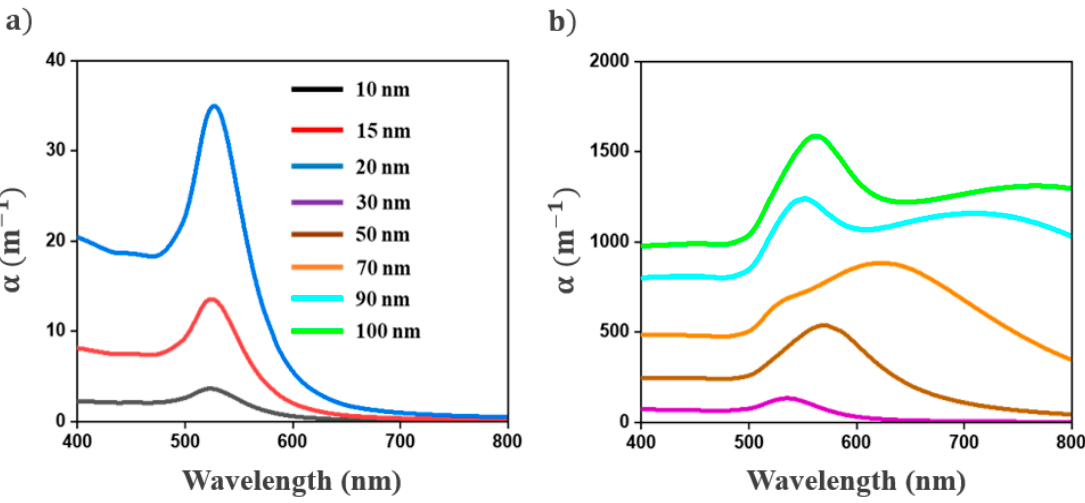
Figure 2. ( a , b ) Evolution of the extinction spectra of gold colloids with NP radius. The concentration of NPs was set to 10 20 m − 3 .